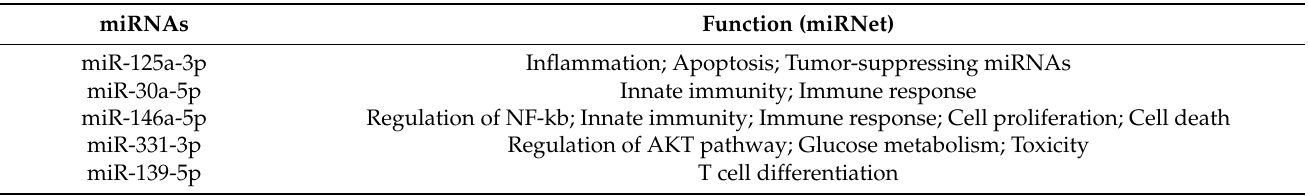
Table 2. miRNAs and their regulatory